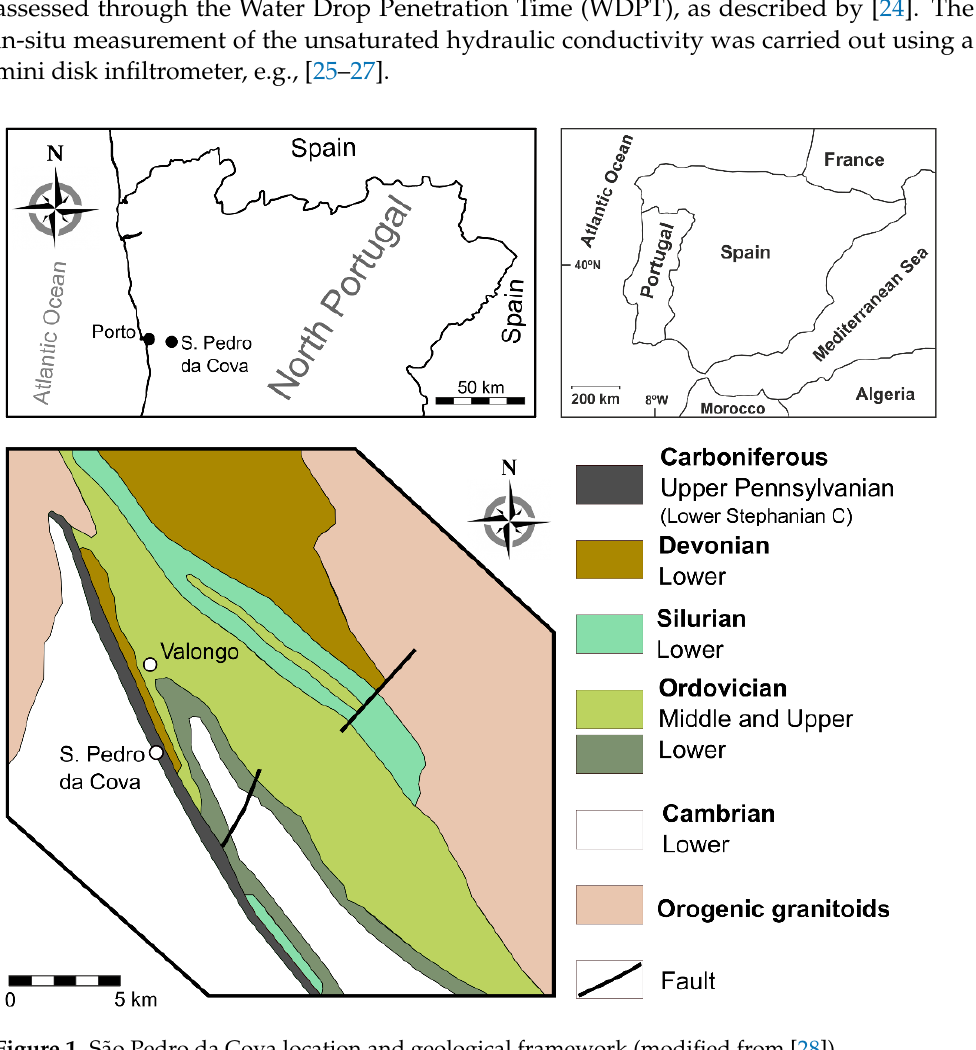
Figure 1. São Pedro da Cova location and geological framework (modified from [28]). Figure 1. S ã o Pedro da Cova location and geological framework (modified from